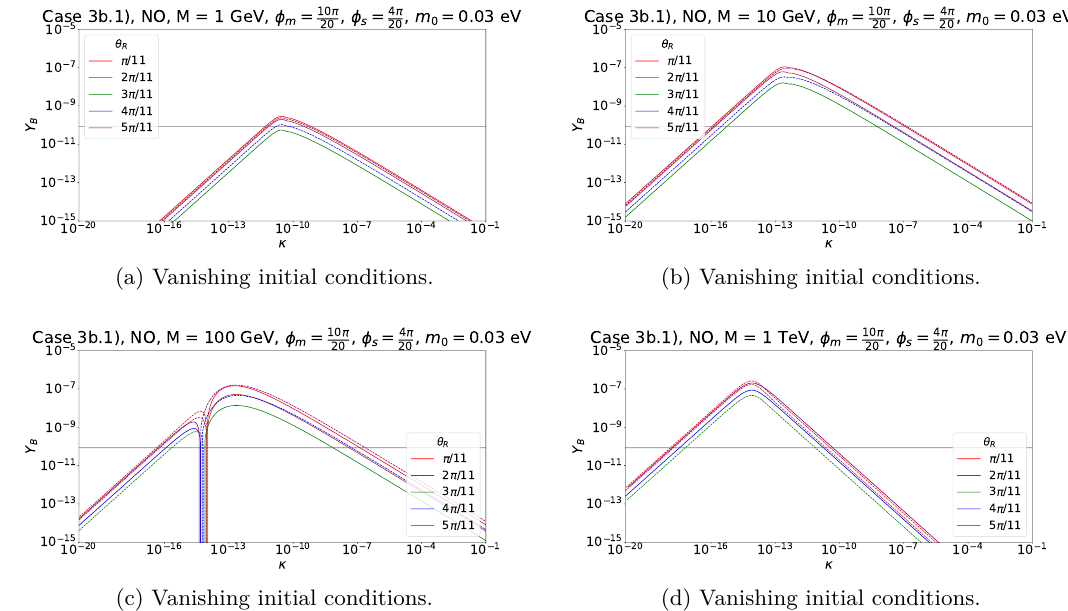
Figure 20 . Case 3 b.1) Y B as function of the splitting κ for a Majorana mass M = 1 GeV (upper left plot), M = 10 GeV (upper right plot), M = 100 GeV (lower left plot) and M = 1 TeV (lower right plot). For each of these plots, different values of θ have been studied. The group theory R parameters n , m and s are fixed to n = 20 , m = 10 and s = 4 so that φ = 10 π and φ = 4 π . m s 20 20 Light neutrino masses are assumed to follow NO with m = 0 . 03 eV. Both negative (dashed lines) 0 as well as positive (continuous lines) values of the BAU are represented. The grey line indicates the observed value of the BAU, Y 8 . 6 · 10 − 11 B ≈